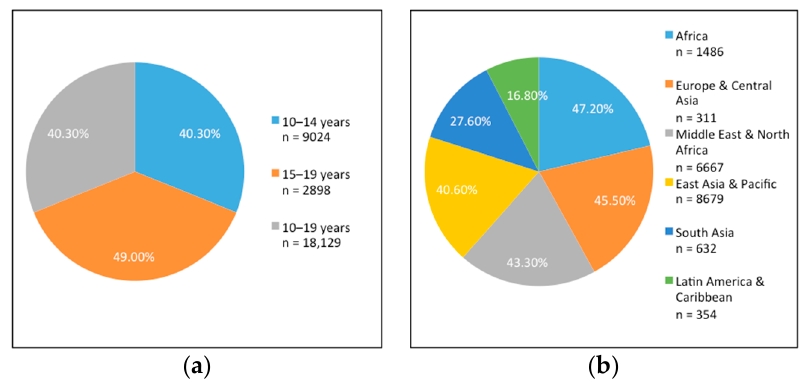
Figure 7. ( a ) Proportion of breakfast skipping practice among adolescent girls by age group. ( b ) Proportion of breakfast skipping practice among adolescent girls by region.